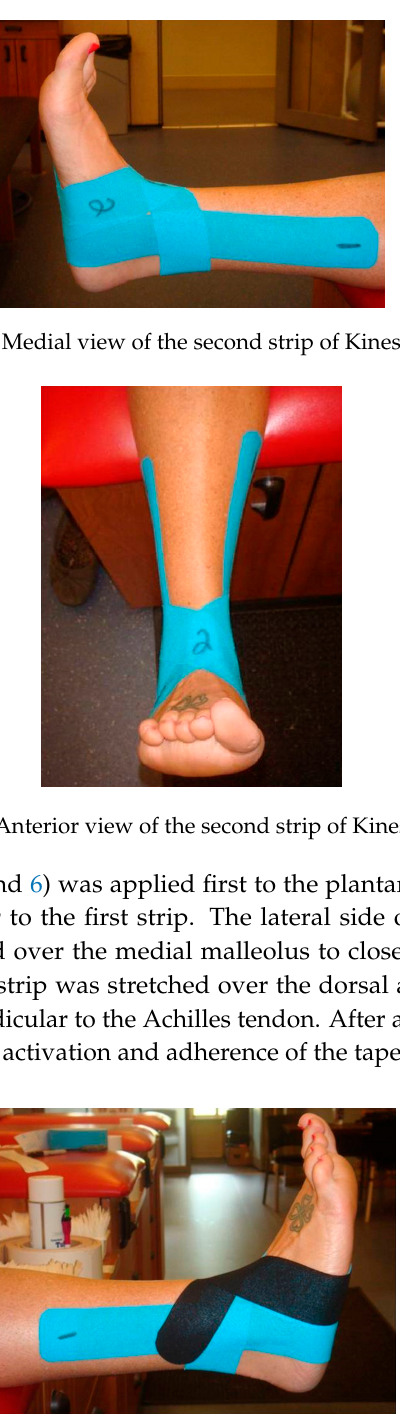
Figure 5. Lateral view of the third strip of Kinesio tape.